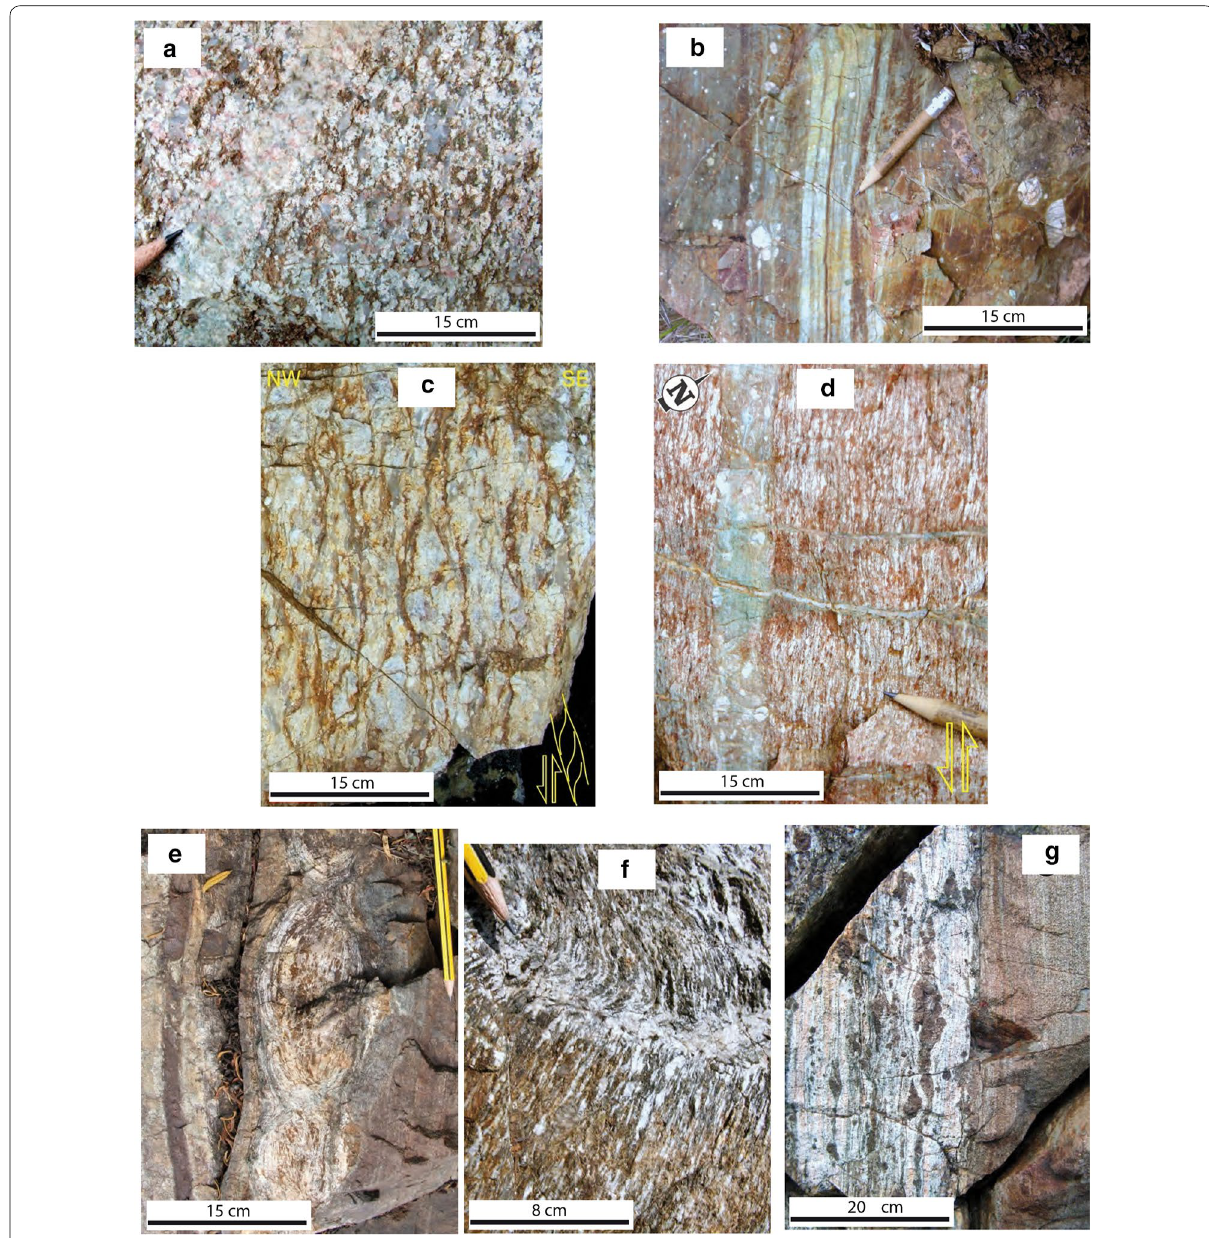
Fig.11 a Coarse-grained tonalite of the Granite Complex, showing magmatic to submagmatic fabric which is highlighted by aligned euhedral to subhedral plagioclase phenocrysts, aggregates of biotite flakes and quartz ribbons; b Sheared pegmatite, intruded into gabbro-norite, from western margin of SLSZ (see Fig. 10c, d). This pegmatite was intruded and sheared along the SLSZ during isothermal decompression from ~ 0.7 to 0.5 GPa at 800 °C (Zibra et al. 2012 and Fig. 10e,f); c Coarse-grained granitic gneiss along the contact between Granite Complex and Diorite-Granite complex (Bocca Civenti Shear Zone). Natural section nearly perpendicular to mylonitic foliation (subvertical) and subparallel to the stretching lineation. S/C and C’ subfabrics indicate sinistral shear; d Mylonitized intrusive contact between a granite pegmatite and host gabbro–norite, near the top of the SLSZ. Sinistral shear sense indicated by σ-type mantled K-feldspar (in pegmatite) and plagioclase porphyroclasts (in gabbro–norite); e , f Outcrop-scale evidence of melt-present deformation ( e ) boudinaged pegmatoid Opx-bearing tonalite, previously injected into the host melagabbro. Boudin neck is locally filled by undeformed leucotonalite (f), interpreted to have been a melt. Stretched Opx porphyroclasts may be observed adjacent to the vein boundaries; ( g ) Mylonitic fabric affecting felsic granulite and meta-gabbro-norite. Shear bands and asymmetric porphyroclast systems show sinistral shear sense (more details in Zibra et al.